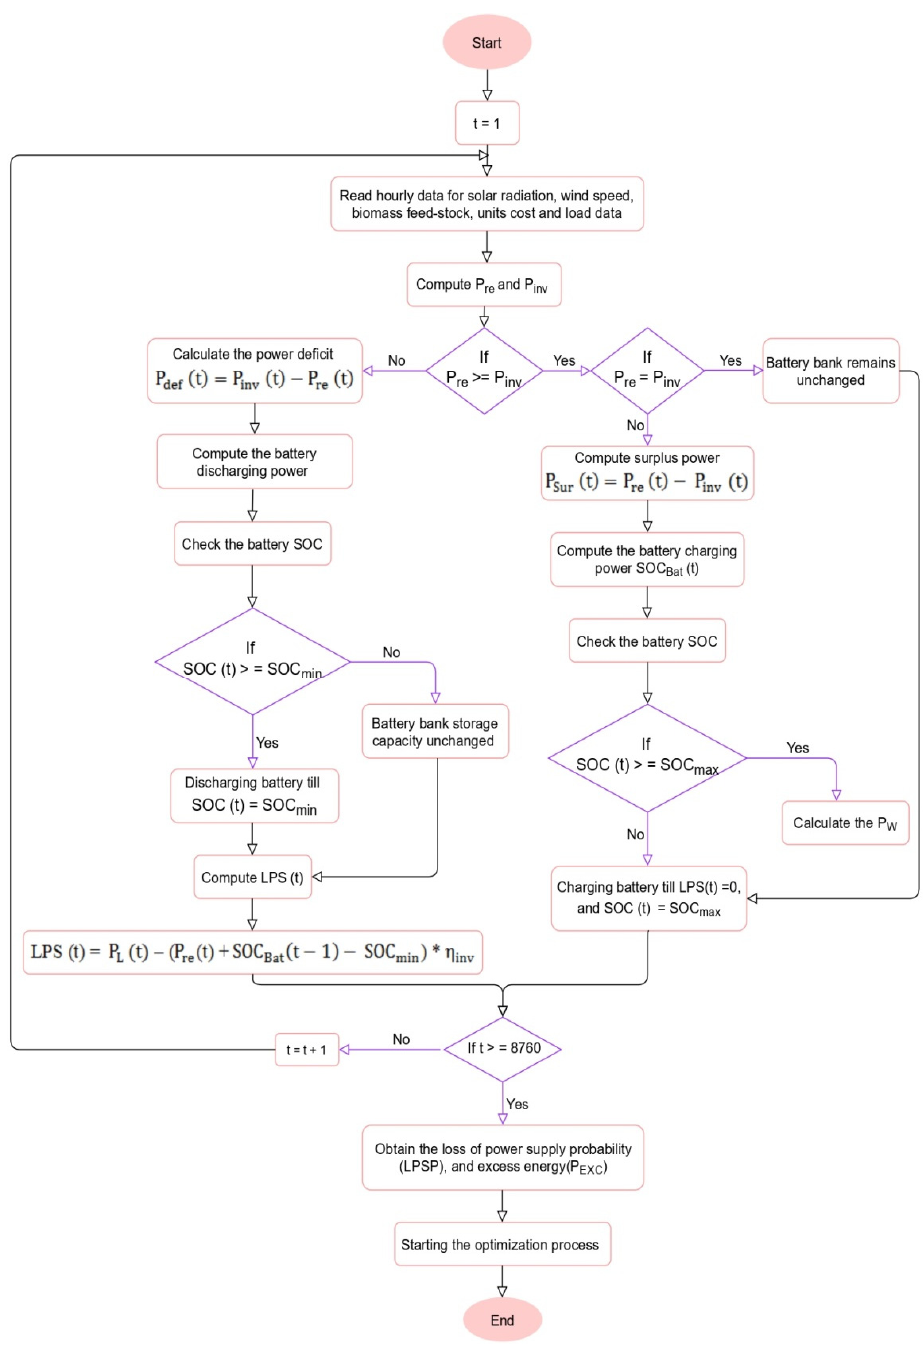
Figure 7. Flowchart of the operating management